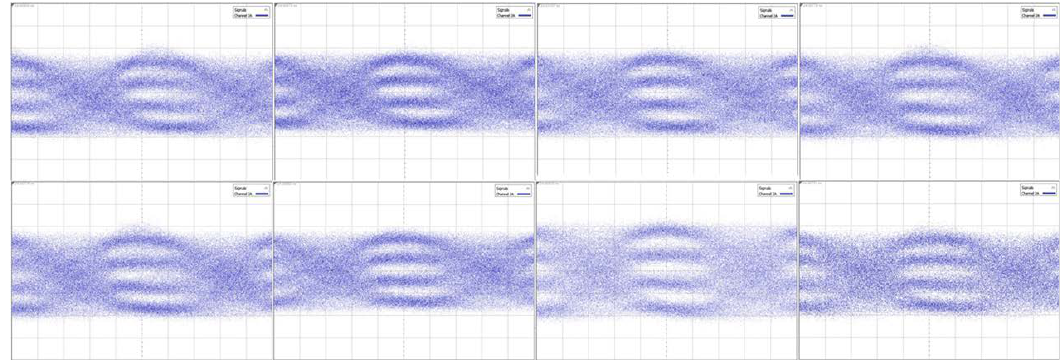
Figure 7. Optical eye diagrams of eight wavelength division multiplexing (WDM) channels using PAM4 modulation format. Top: channels 1 to 4; bottom: channels 5 to 8.